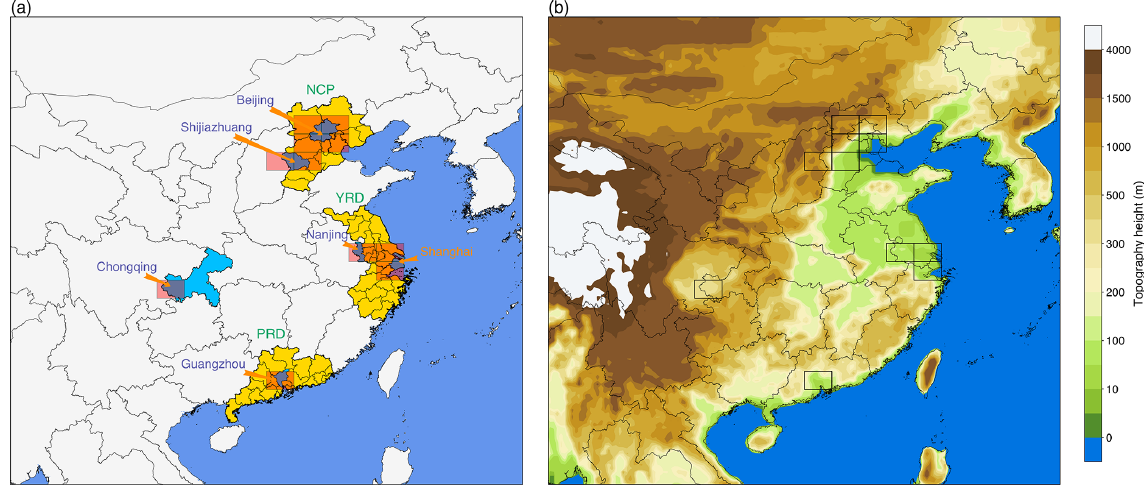
Figure 1. Map of China showing (a) the key provinces (yellow) representing the NCP, the YRD, and the PRD and locations of the six regions (blue) – Beijing, Shijiazhuang, Shanghai, Nanjing, Guangzhou and Chongqing – and UKCA model grid cells co-located with these regions (red); and (b) elevations across the whole of China.